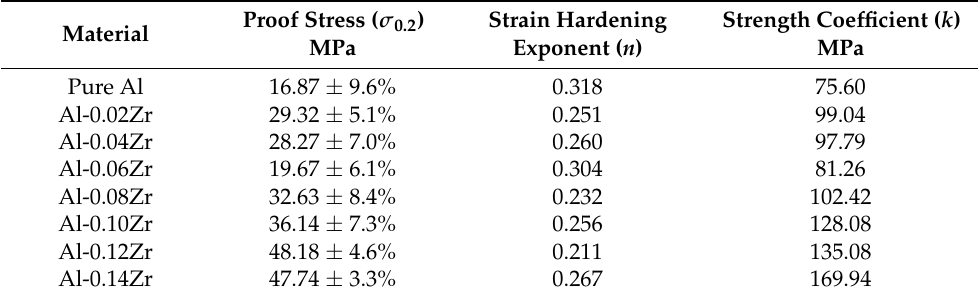
Table 3. Mechanical behavior parameters as extracted from the tensile experiments for all exam- ined specimens.